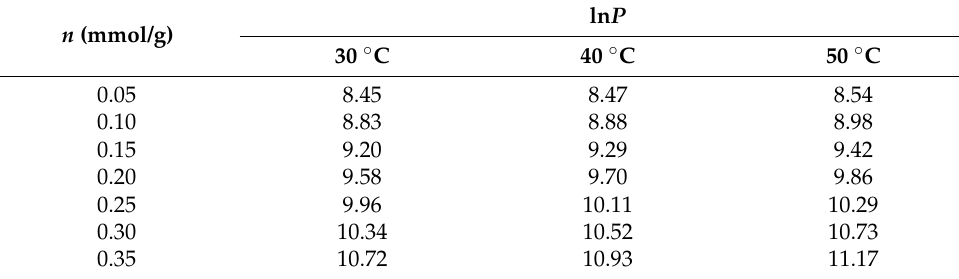
Table 6. Calculation results of ln P at different temperatures.